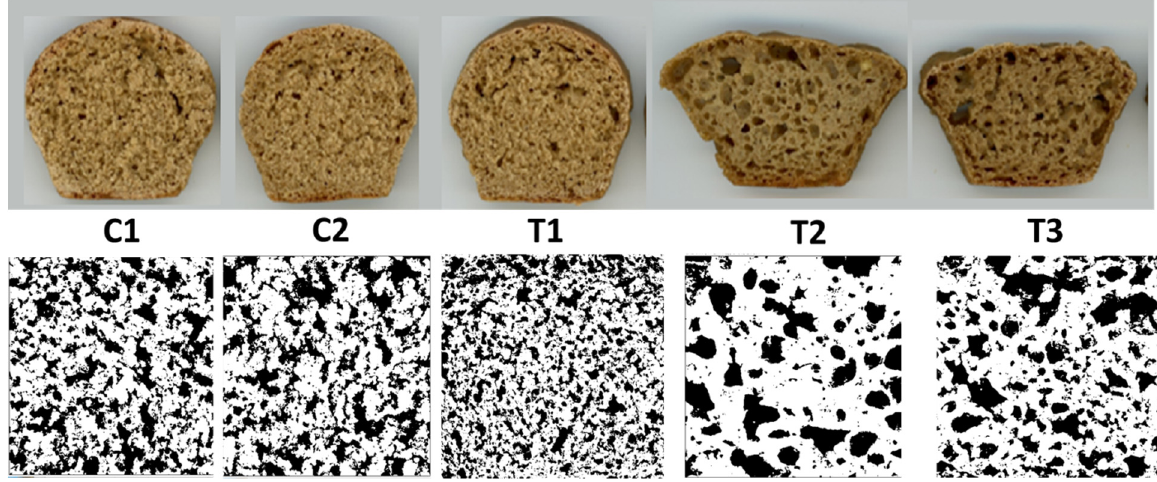
Figure 3. Slices ( top row ) and crumb scans ( bottom row ) of IWG bread formulated without pretreated bran (C1), without pretreated bran but with added xylanase (C2) or ascorbic acid (T1), with xylanase pretreated bran as-is (T2) or with added ascorbic acid (T3).